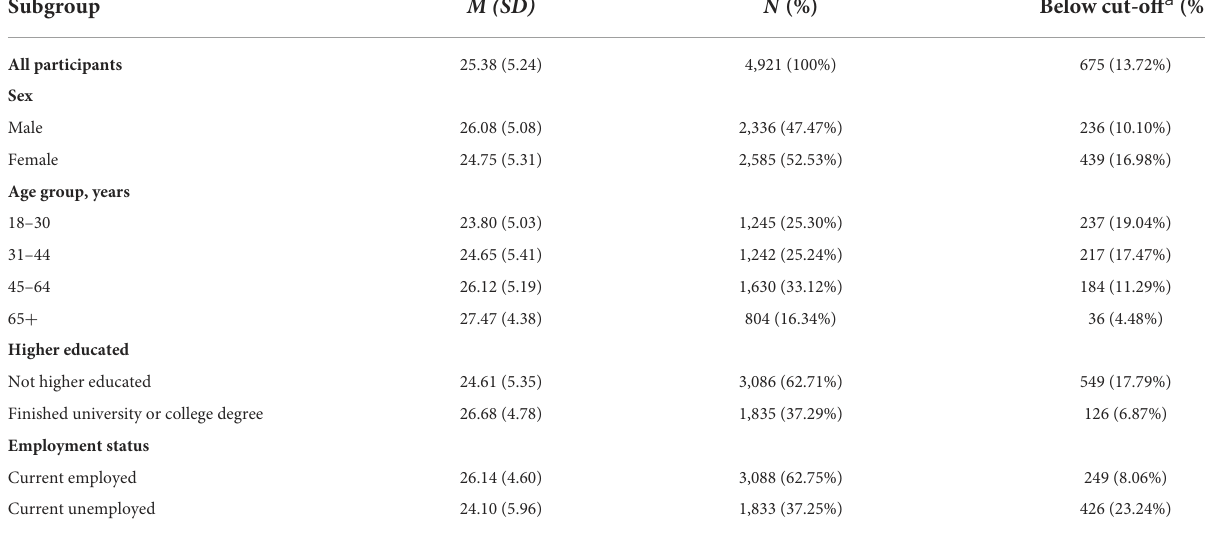
TABLE 2 Table of scores of well-being